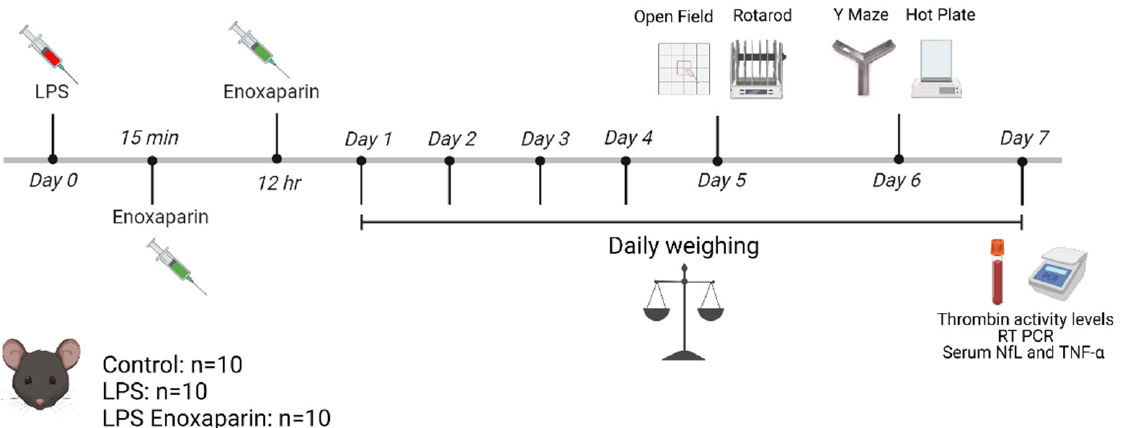
Figure 6. Timeline: The experiment was repeated twice. LPS was induced in 20 animals on Day 0. 10 animals in the LPS group were treated with two injections of enoxaparin on the same day. Motor performance was assessed by the rotarod on day 5. Cognitive parameters were assessed on days 5 and 6 by the open field test and Y-maze, respectively, and sensory evaluation was conducted on day 6 by the hot plate test. Animals were sacrificed on day 7 for thrombin activity, RT-PCR, and serum NfL and TNF- α quantifications. Animals were weighed daily. LPS—lipopolysaccharide, RT PCR—real time polymerase chain reaction, NfL—neurofilament light chain, TNF- α —tumor necrosis factor α . Created with BioRender.com.